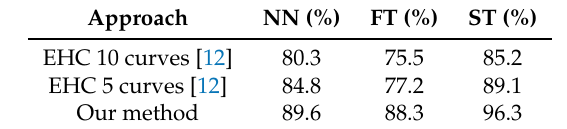
Table 5. Pose retrieval comparisons of our method with the one in [12].